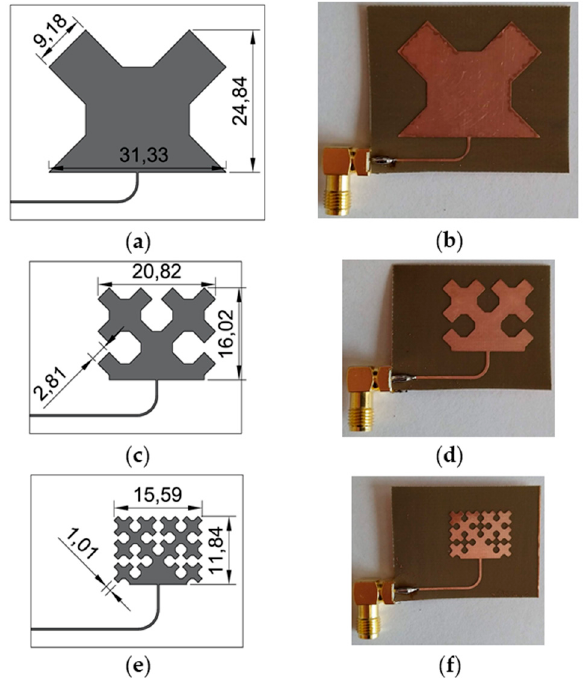
Figure 1. Construction method of Sierpinski curve fractal.